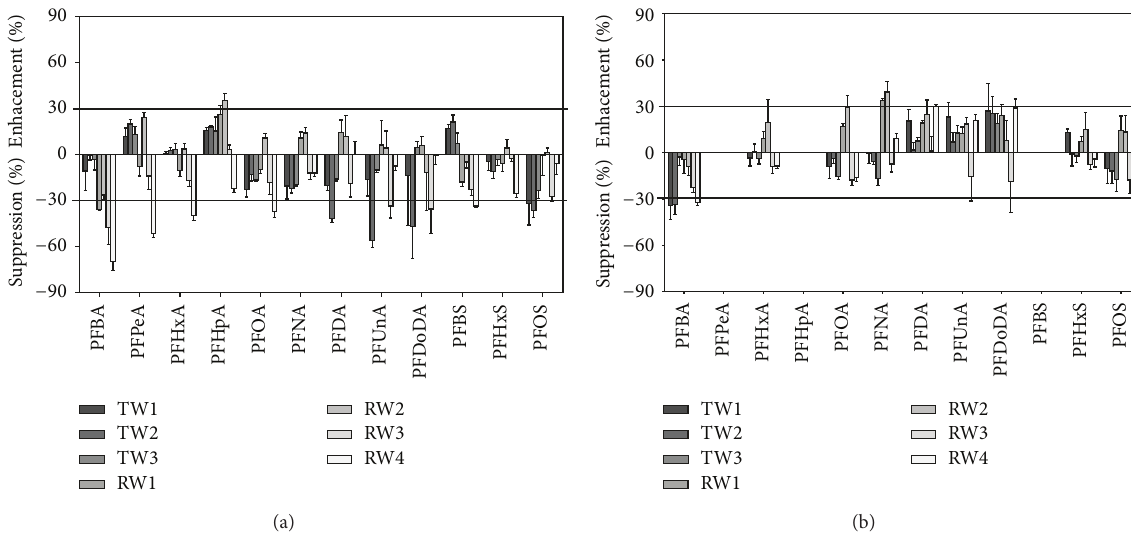
Figure 4: Not corrected (a) and corrected by SIL-IS (b) total matrix effects (%). TW1 and TW2 are drinking water samples produced from ground water; TW3 is a drinking water sample produced from lake water. RW1 and RW3 are water samples collected in low polluted rivers; RW2 and RW4 are water samples collected in a river impacted by industrial discharges and in an organic polluted river, respectively. Spiked concentration of native and coeluting SIL-IS at 100ng/L